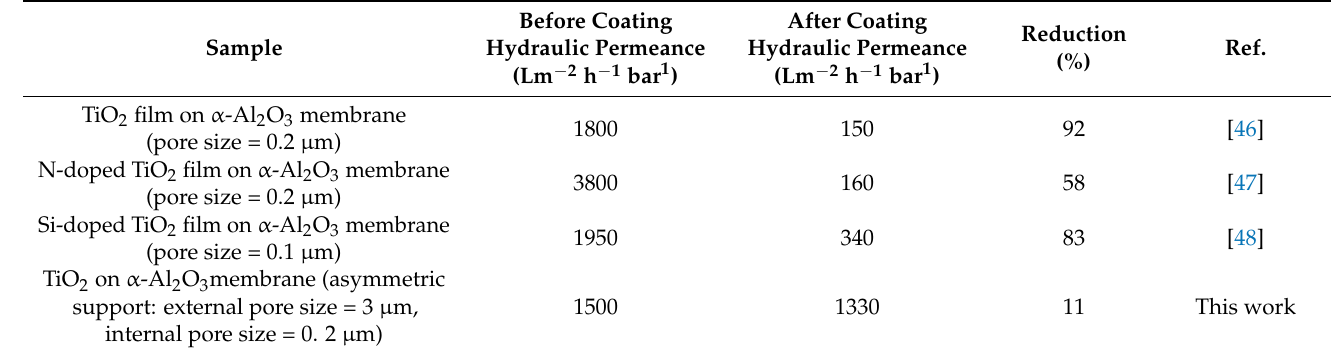
Table 4. Comparison with the water permeabilities of different inorganic photocatalytic